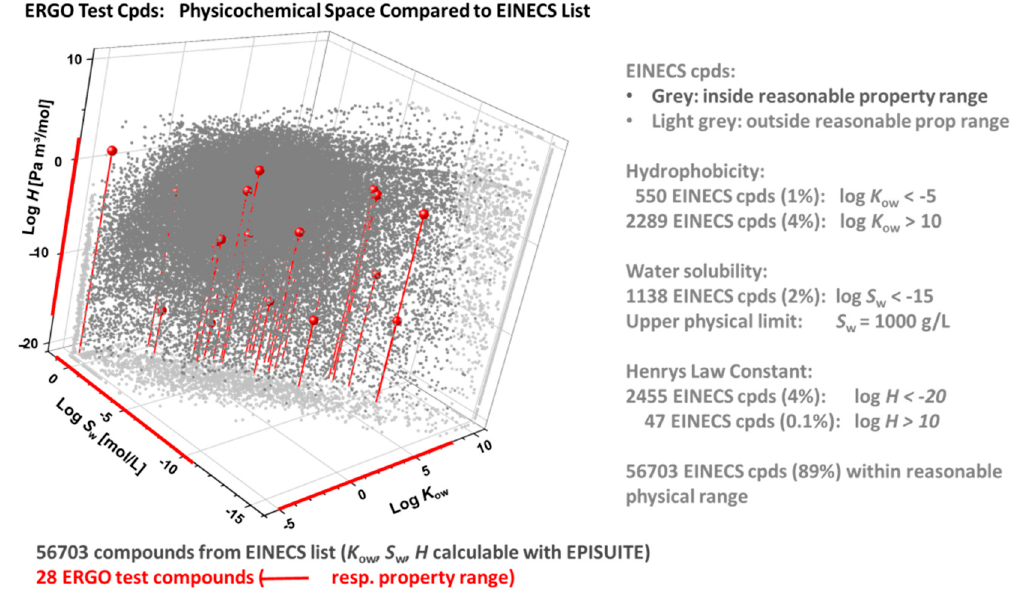
Figure 7. ERGO vs. EINECS physicochemical domain in terms of log K ow (octanol-water partition coe ffi cient), log H (Henry’s law constant) and log S w (water solubility), as calculated through EPISuite [51]. Among 100,102 EINECS entries, 72,520 have defined chemical structures, of which 56,703 compounds with formally valid EIPSuite results (grey) are compared to the 28 ERGO reference compounds (red). EINECS compounds with calculated properties outside reasonable ranges are plotted in the property edges (light